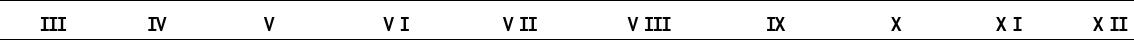
Table 2. Multiethnity and Social Network Diversity: Summary of Main